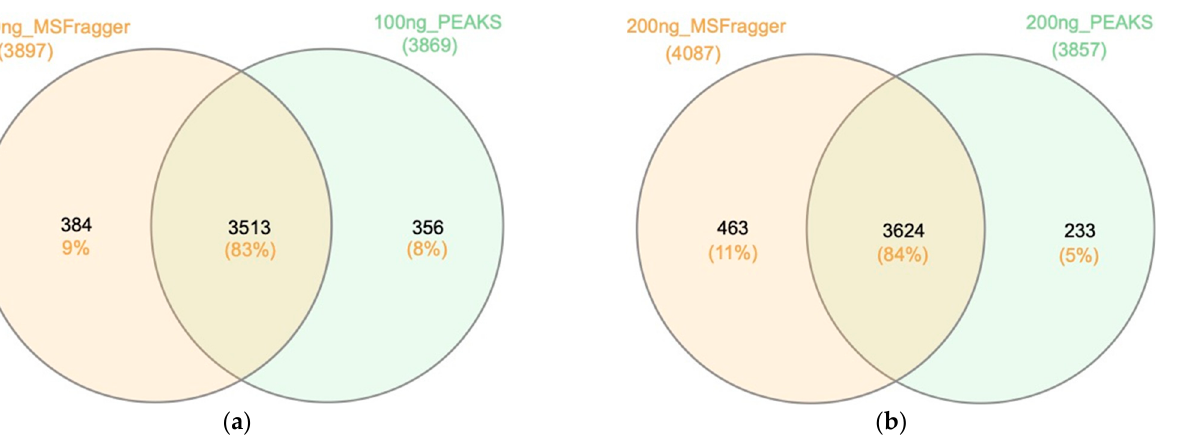
Figure 10. Proteome overlap of two search engines. Venn diagram showing overlapping identified protein groups between MSFragger and PEAKS Studio for the data acquired under a 44 min step- linear gradient ( a ) using 100 ng of HeLa digest; and ( b ) using 200 ng of HeLa digest.